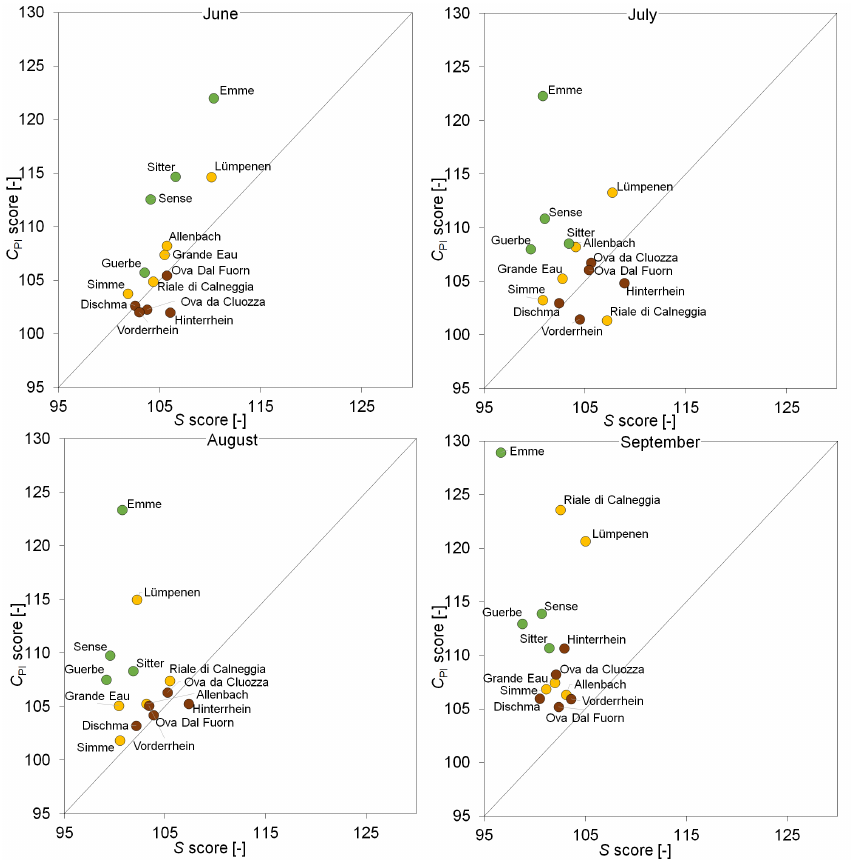
Figure 9. Score plots indicating the combined effect of snow and liquid precipitation on low flows in the different months (four plots for June to September). Points below the one-to-one line indicate catchments with a stronger effect of maximum SWE on low flows compared to spring and summer precipitation (expressed as C PI ) and vice versa. The colour of the circle indicates the catchment group according to mean elevation (dark brown: > 2000ma.s.l.; light brown: 1300–2000ma.s.l.; green: <